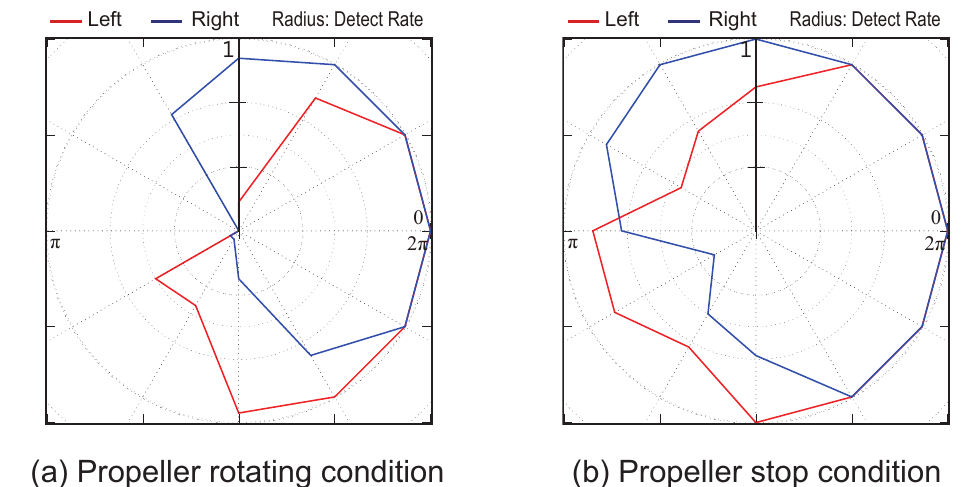
Figure 12. Detection rate results of left and right alcohol sensors at the wind speed of 1.0 m/s. Subfigure ( a ) shows the state in which the propellers of the quadcopter rotate; subfigure ( b ) shows the result for the propellers of the quadcopter